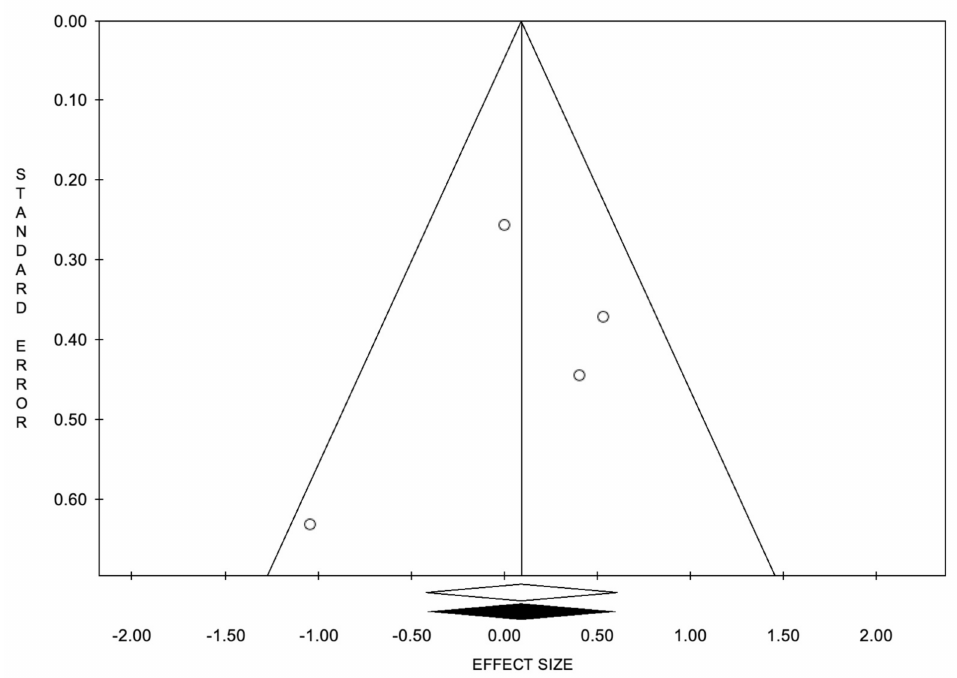
Figure 6. Funnel plots of the meta-analysis evaluating the event rate for 2-year overall survival. Egger’s linear regression (t= − 0.47, p = 0.683) and Begg and Mazumdar’s rank correlation test (z = − 0.68, p =